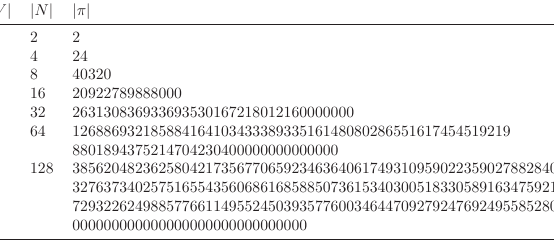
V N π , and are the number of variables of CP-nets, vertices of induced graphs, and | | | | | |